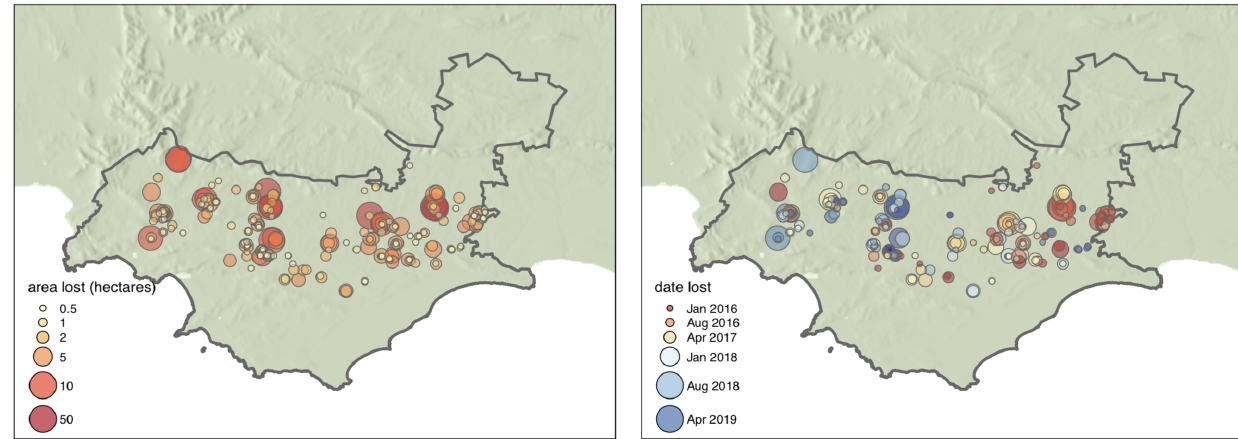
Figure 5. The spatial distribution of Renosterveld loss observed in the Overberg district between February 2016 and January 2020. Point size indicates the size of loss events in both panels, whereas colour indicates size ( left ), and the date of loss ( right ).